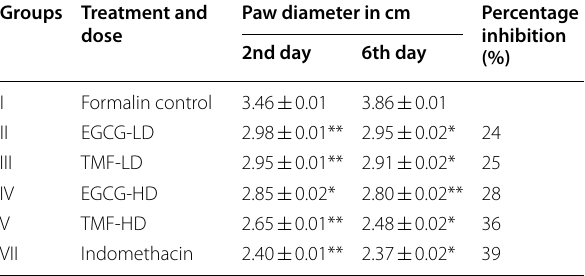
Table 3 Formalin induced arthritis model in WS